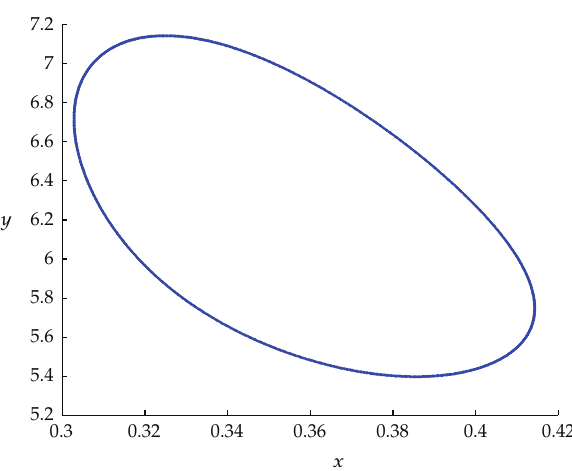
Figure 4: A stable closed invariant curve for a (cid:8) 3 . 5, b (cid:8) 0 . 2, and d (cid:8) 2 .